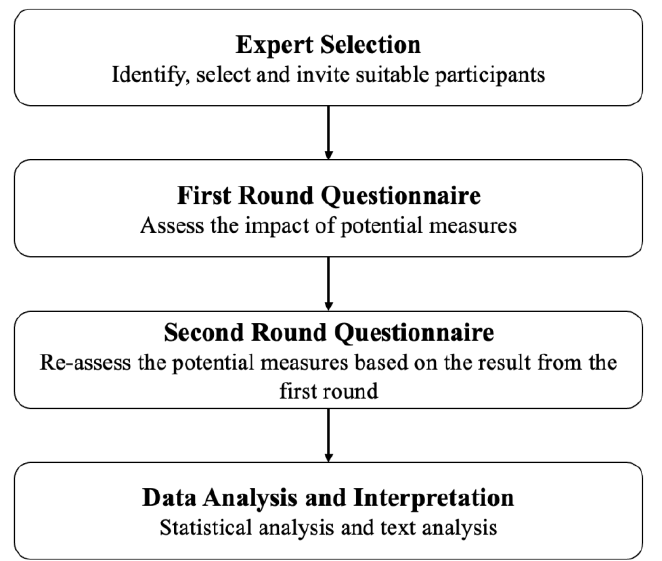
Figure 1. Sequential order of the Delphi